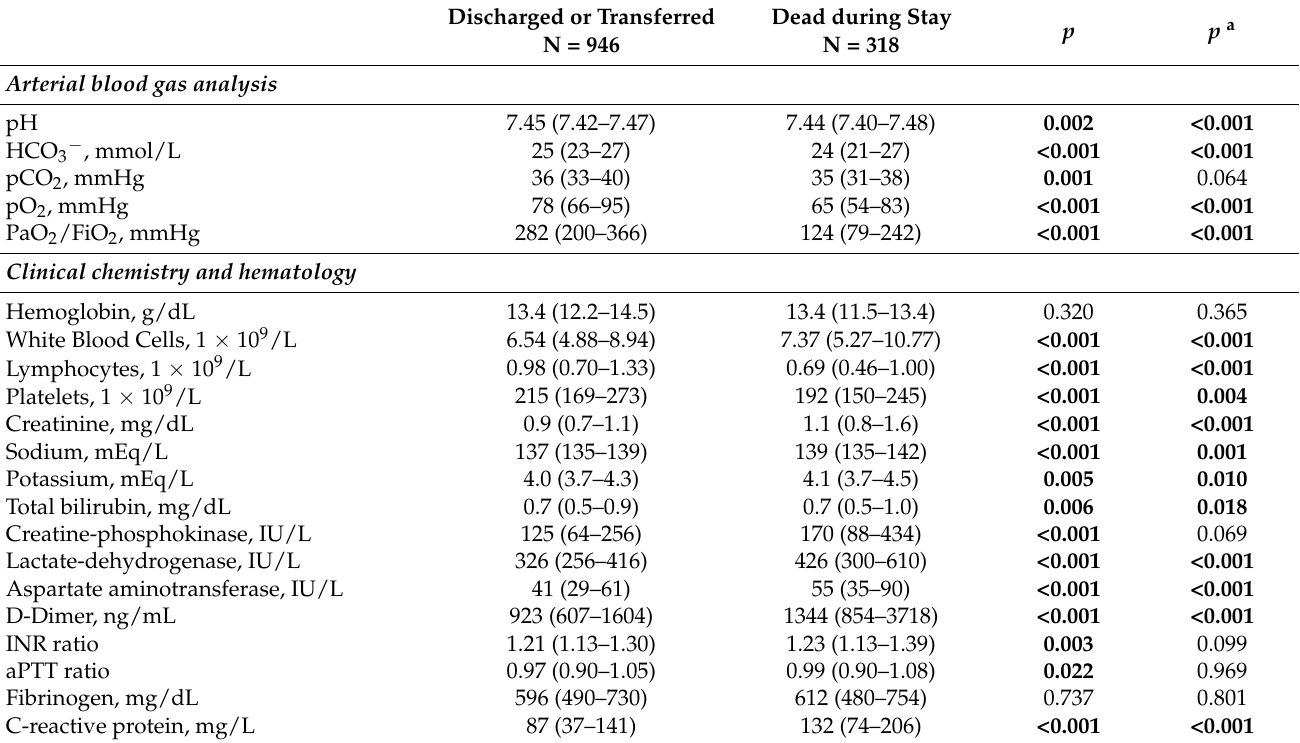
Table 6. Comparison of the laboratory tests performed on admission of patients hospitalized for suspect COVID-19, categorized according to the outcome (discharged/transferred vs. dead during